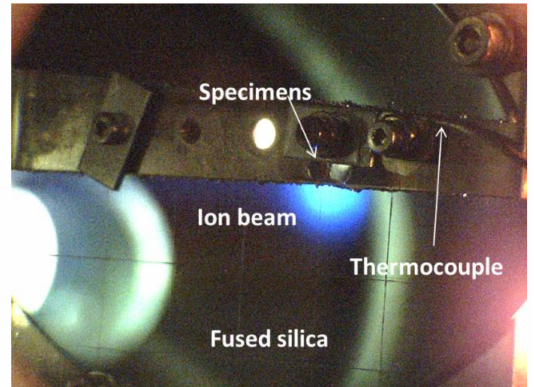
Figure 1. Pure EFDA Fe TEM micrograph showing the main hole and the transparent area after electropolishing with a large and homogeneous thin area ( a ) and a small smooth hole with an excellent electropolished volume irradiated ( b ).